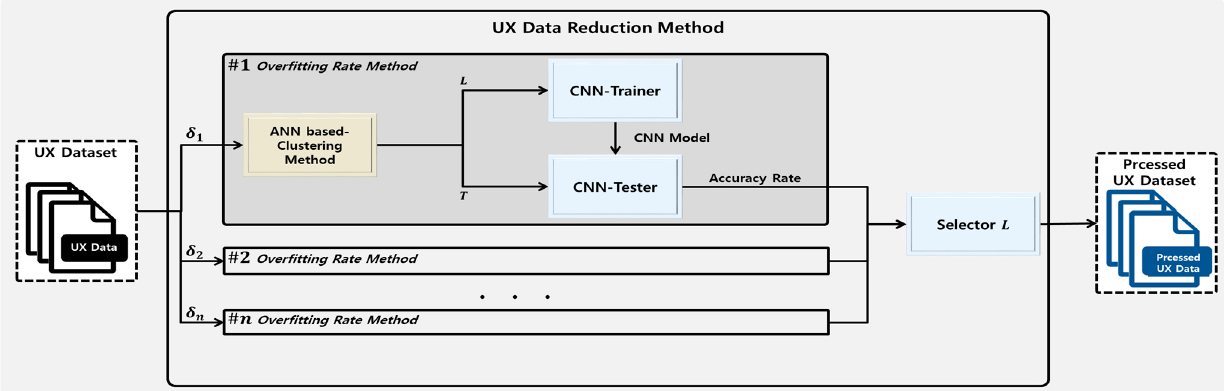
Figure 3. UX data reduction method framework.